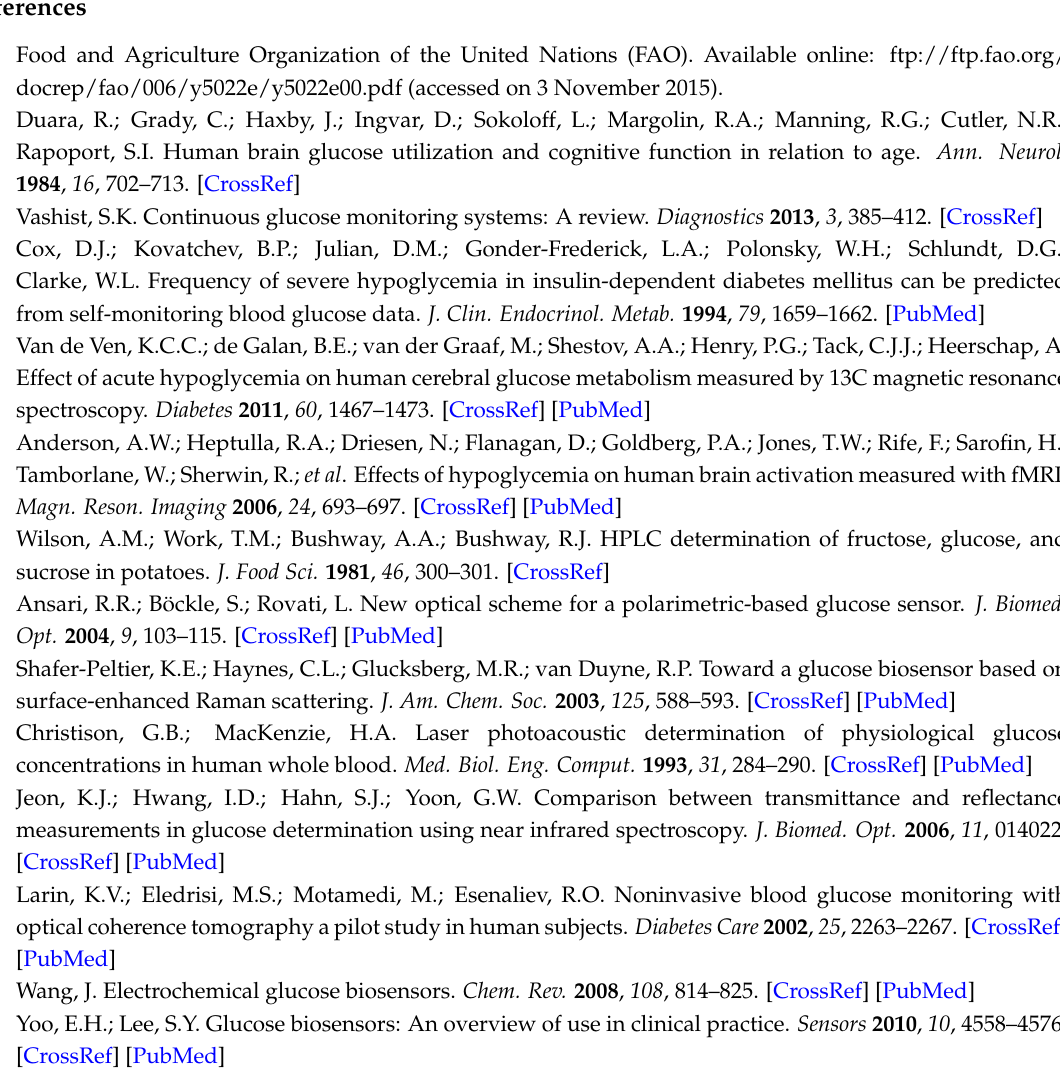
29846/s1, Figure S1: Thermo-gravimetric analysis (TGA) graph of the nickel/carbon composites at a 10 ˝ C/min ramp rate. Figure S2: Cyclic voltammograms of added glucose in serum (line) and serum (dot)